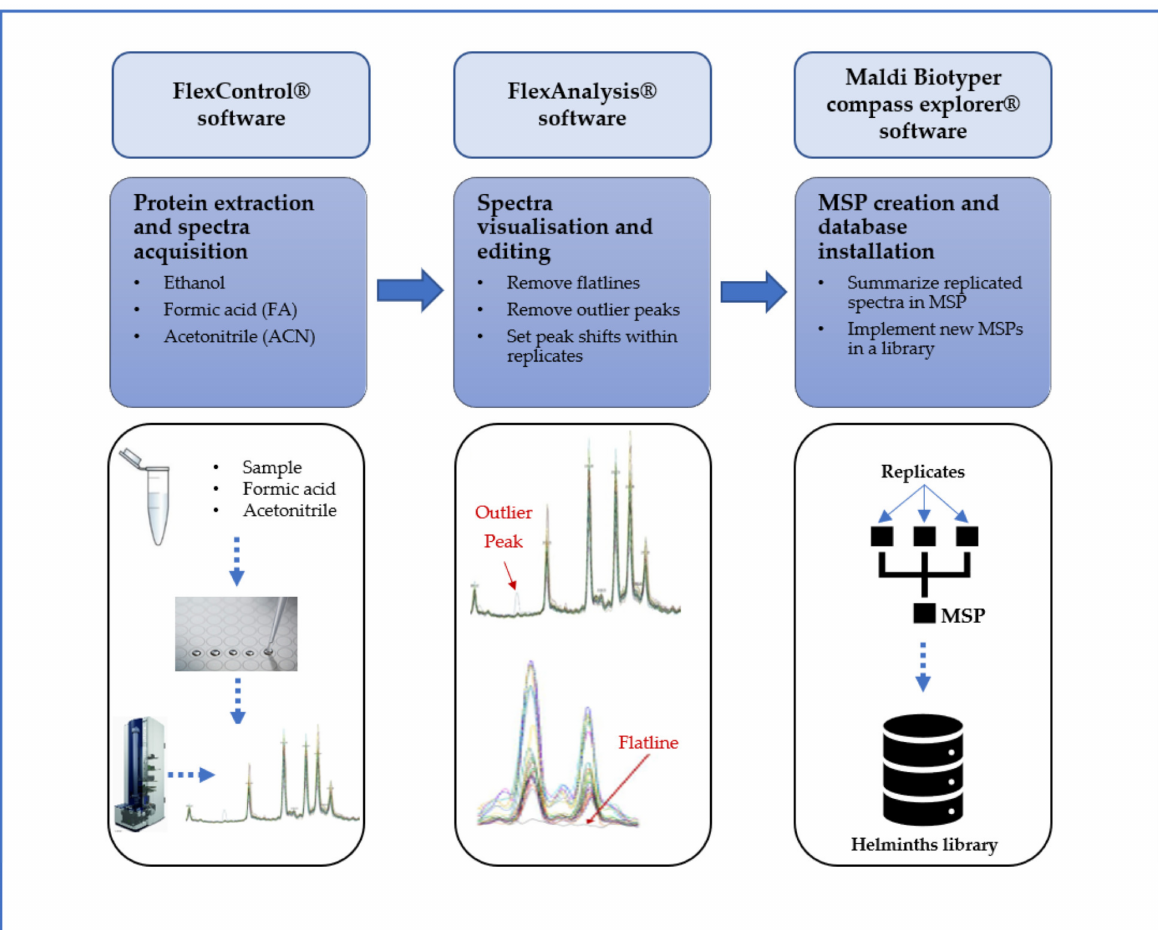
Figure 1. MSP creation and database installation using MBT compass explorer software version 3 (Bruker Daltonics, Bremen,